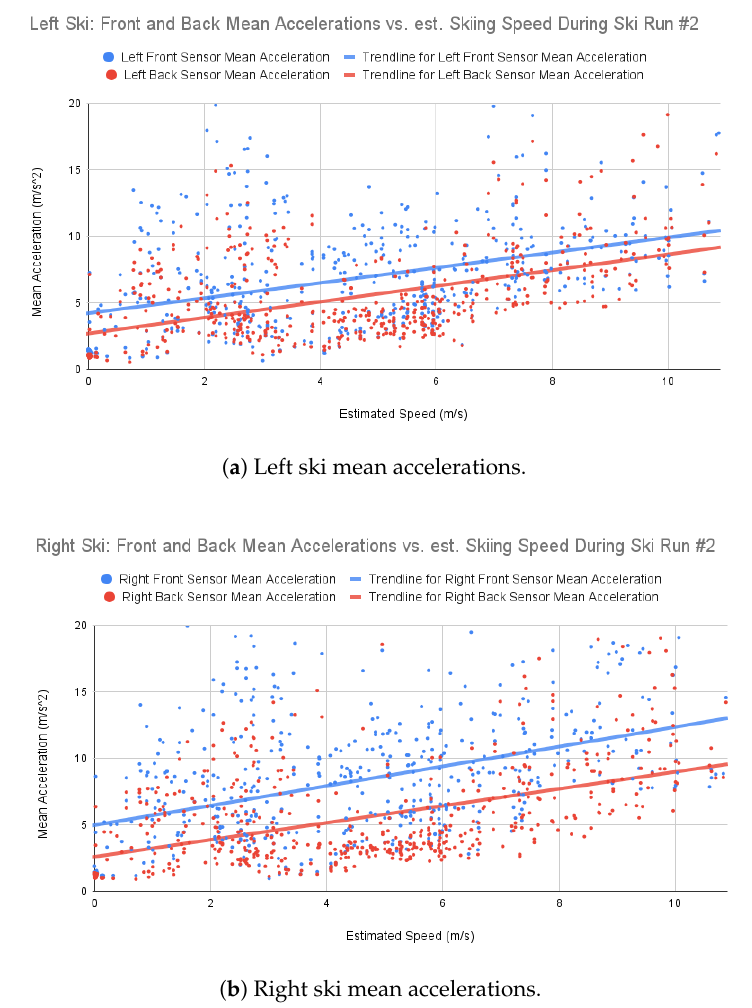
Figure 10. Run #2 left and right ski mean accelerations vs.